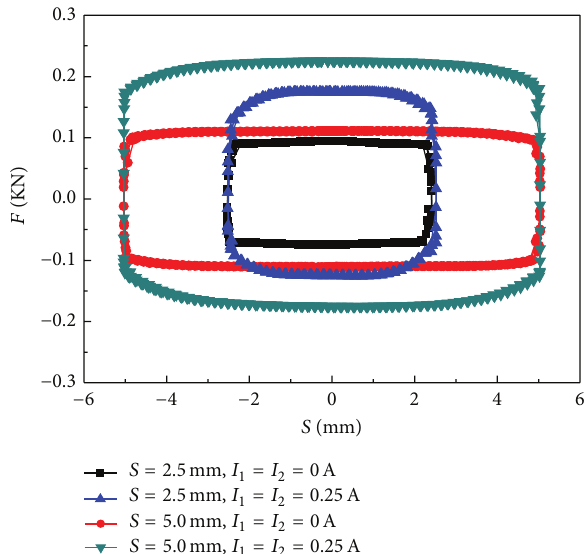
Figure 14: Damping force under different currents and different